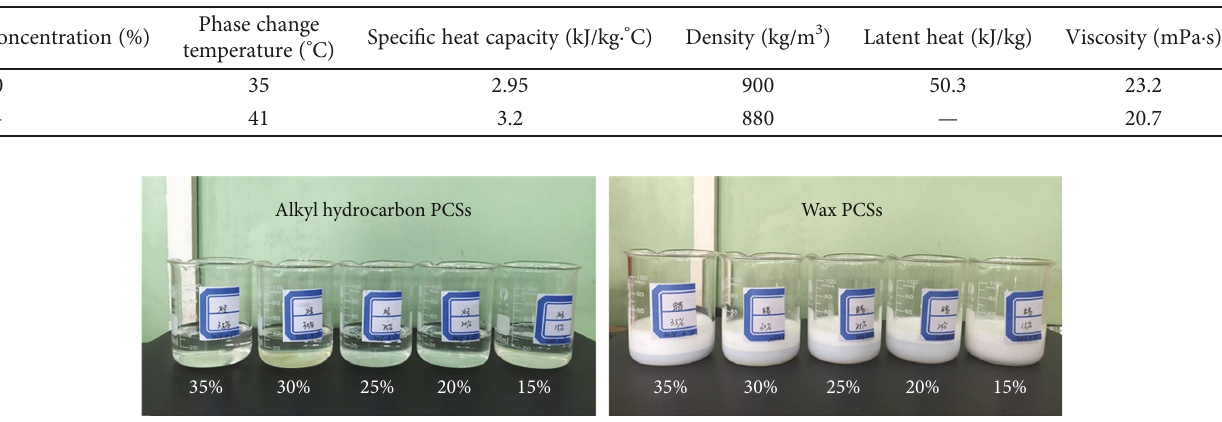
Figure 4: The picture of alkyl hydrocarbon PCS and wax PCS after ten months ’ steady placement.